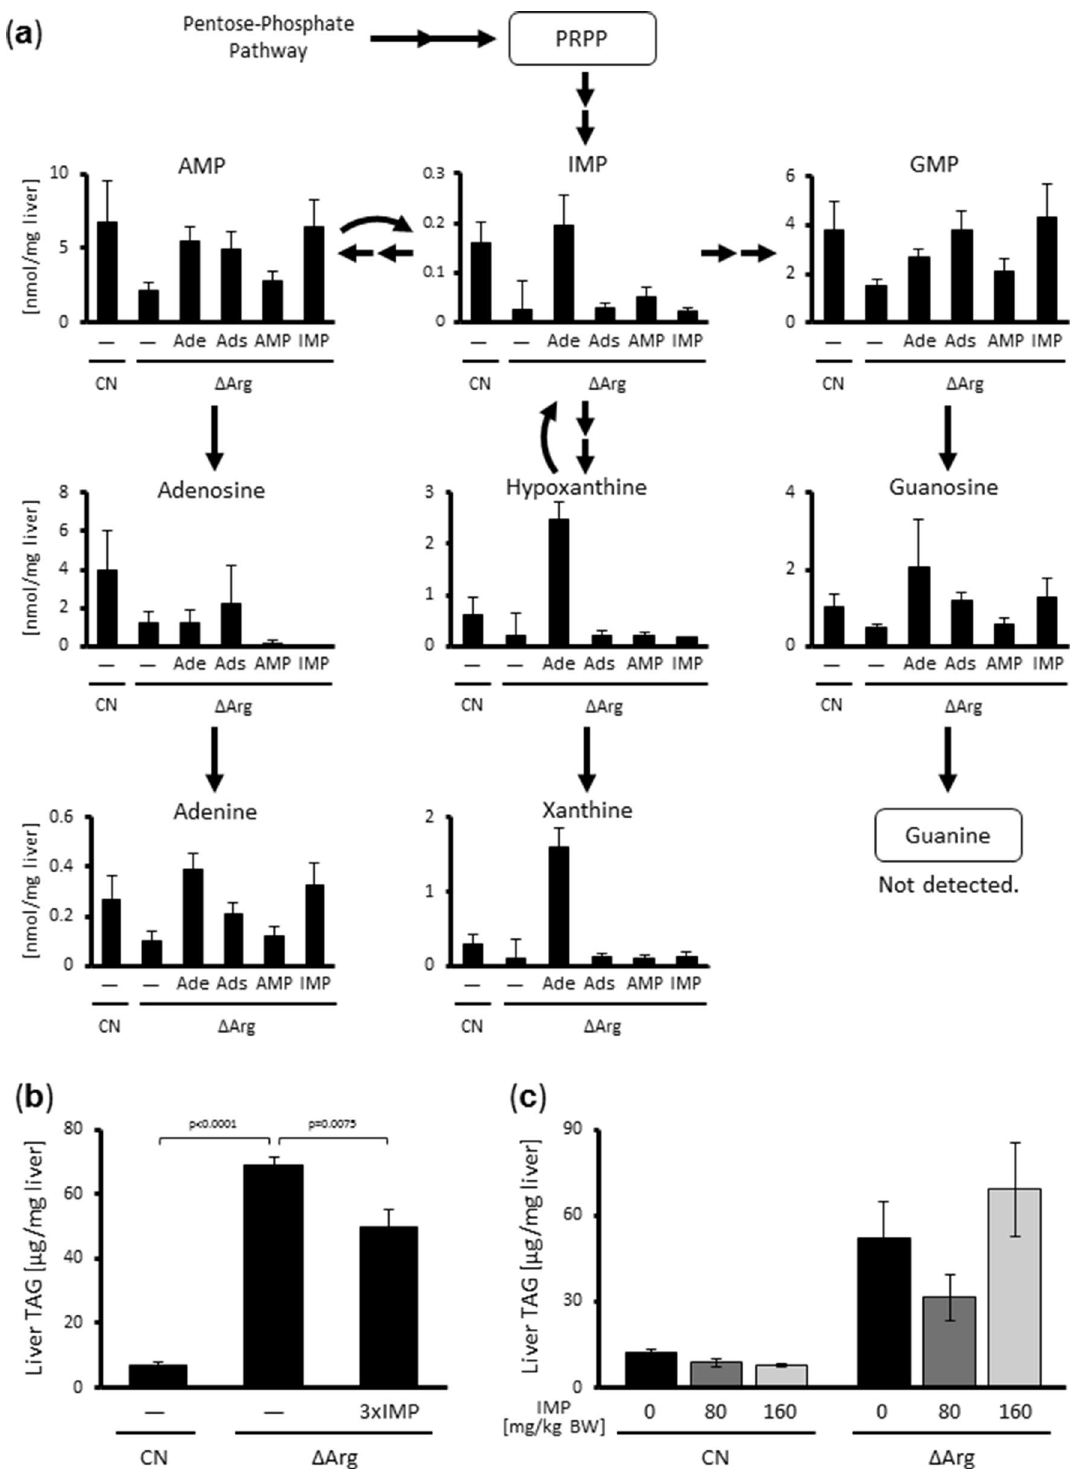
Figure 2. Adenine and related metabolites per se are unlikely to be involved in the hepatic lipid metabolic regulation. ( a ) Schematic diagram of purine metabolism and the levels of each metabolite in the livers of rats shown in Fig. 1d. ( b ) Six-week-old male Wistar rats were fed the CN diet or ΔArg diet with or without 9 g/kg IMP supplement for seven days. TAG levels in their livers were measured. ( c ) Six-week-old male Wistar rats were fed the CN diet or ΔArg diet for seven days. 80 or 160 mg/kg body wt. of IMP solution or just saline was injected via the tail vein at day 1, 3, and 5 after beginning of experimental diets. TAG levels in the livers were